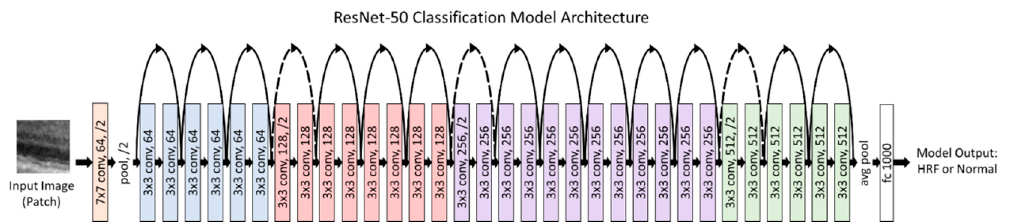
Figure 2. ResNet50 model for HRF patch classification.